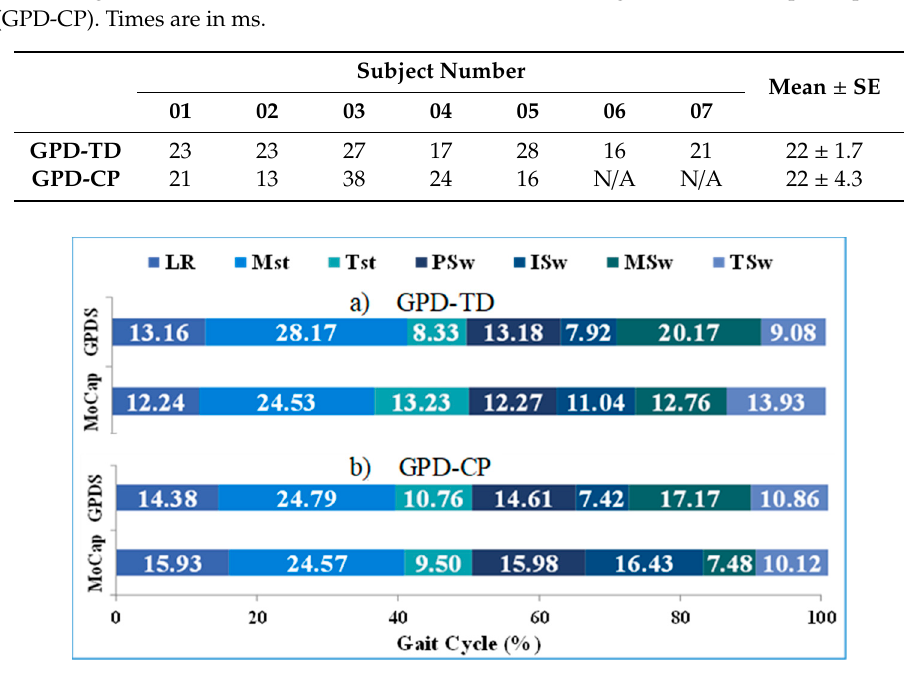
Figure 5. Gait phase duration relative to motion capture (MoCap) as a precentage of gait cycle for ( a ) CP gait phase detection (GPD) and ( b ) typically developing (TD) GPD. Each color indicates a gait